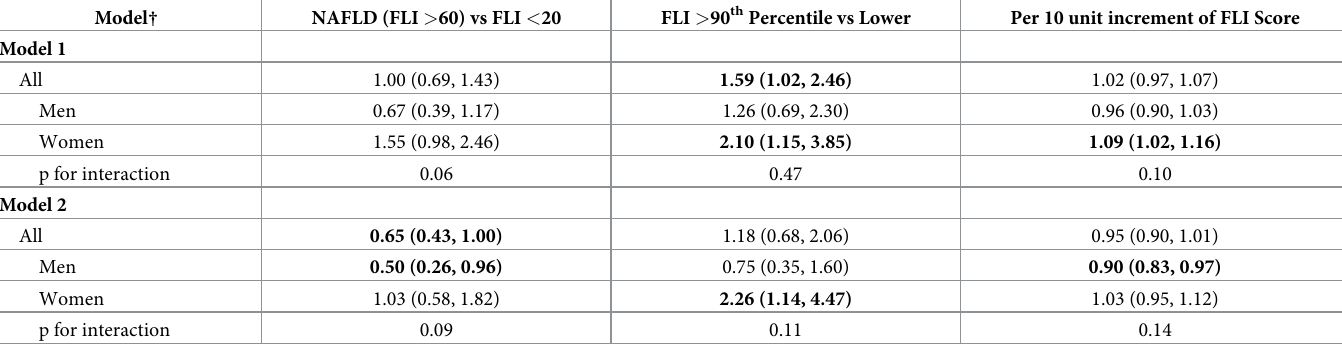
(cid:3) Hazard ratios shown in bold were statistically significant based on the confidence interval † Model 1: adjusted for age, race, and age (cid:3)